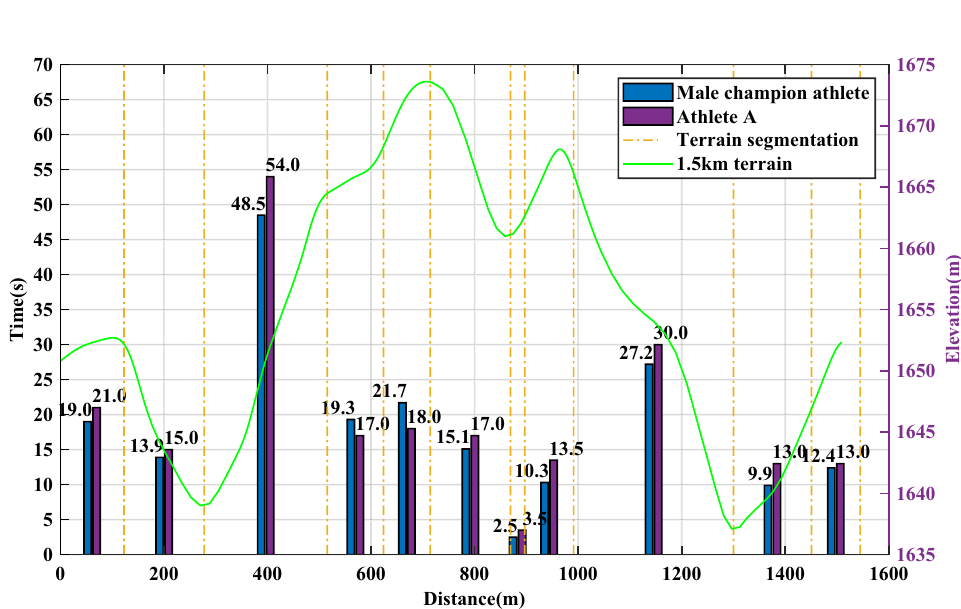
Figure 12. Time distribution comparison of athlete A and male champion